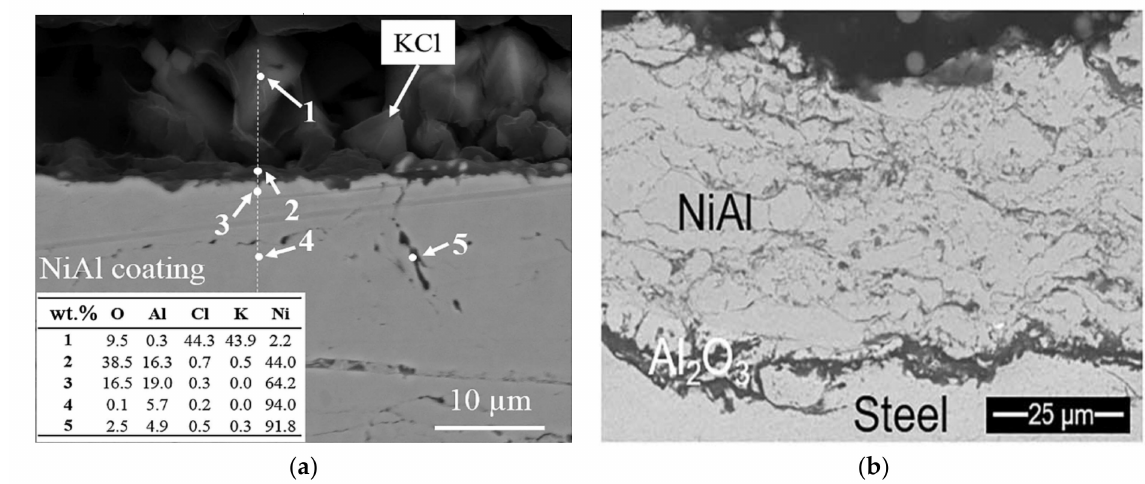
Figure 5. ( a ) Cross-sectional SEM micrograph (BSE) of the Ni5Al coating oxidized in 5% O 2 + 500 ppm HCl + N 2 for 168 h at 600 ◦ C with KCl deposit [58]. ( b ) Cross-sectional BSE images of Ni31Al coating after corrosion at 700 ◦ C for 250 h in synthetic gas with 500 ppm HCl and 10% KCl ash deposit